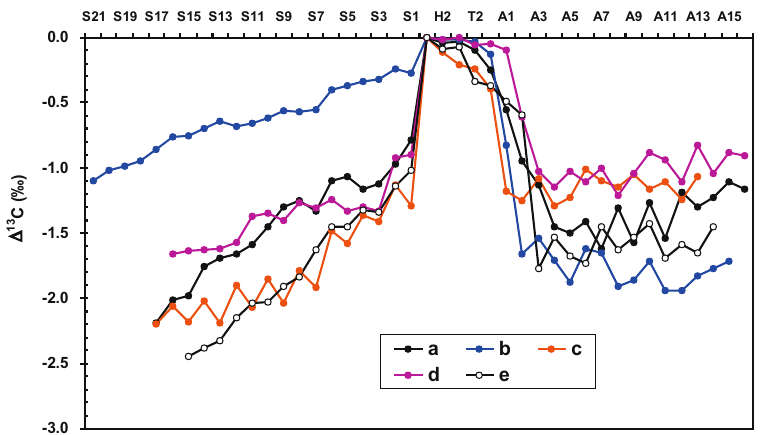
Figure 3. Variations of the Δ 13 C values between the δ 13 C values of the head section (H1) and others in C . sinensis . Samples ( a , b , c , d and e ) were produced from Changdu, Guoluo, Haxiu, Litang and Naqu, respectively. Each sample was sectioned into about 40 pieces from the stroma top to the sclerotium end. These sample sections contain four subsample groups according to their relative positions: stroma (S1 to S i ), head (H1 to H2), thorax (T1 to T3), and abdomen (A1 to A i